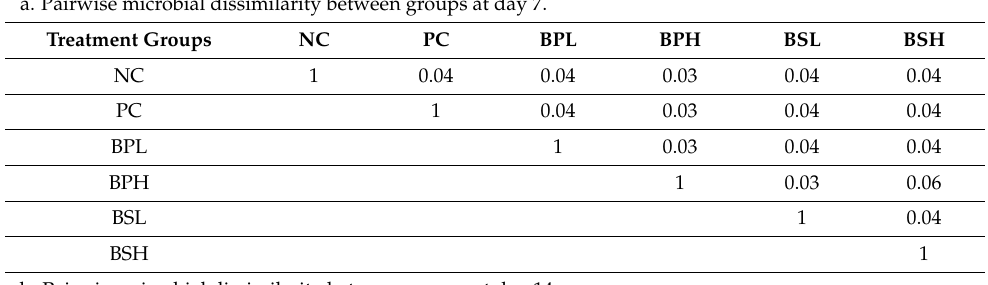
Table 2. Pairwise microbial community dissimilarity (beta diversity) in response to dietary treatments between groups at days 7 ( a ), 14 ( b ), 28 ( c ), and 42 ( d ) and within groups between different timepoints ( e ). a. Pairwise microbial dissimilarity between groups at day